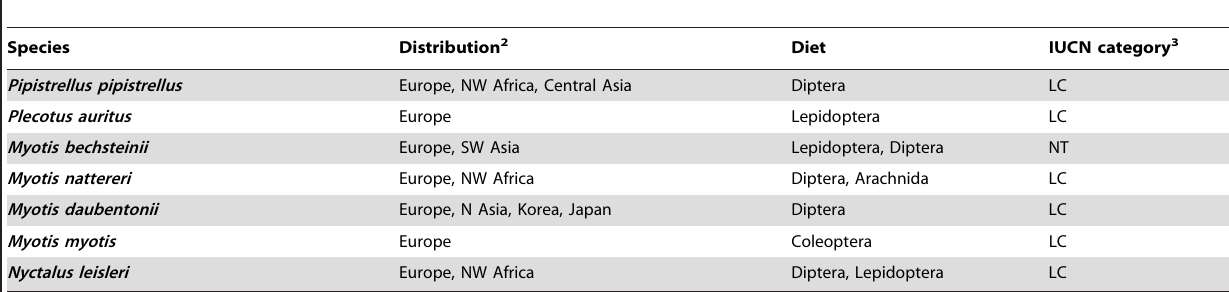
Table 1. Distribution [40], main prey items [5,41] and IUCN 1 category [40] of studied bat species.